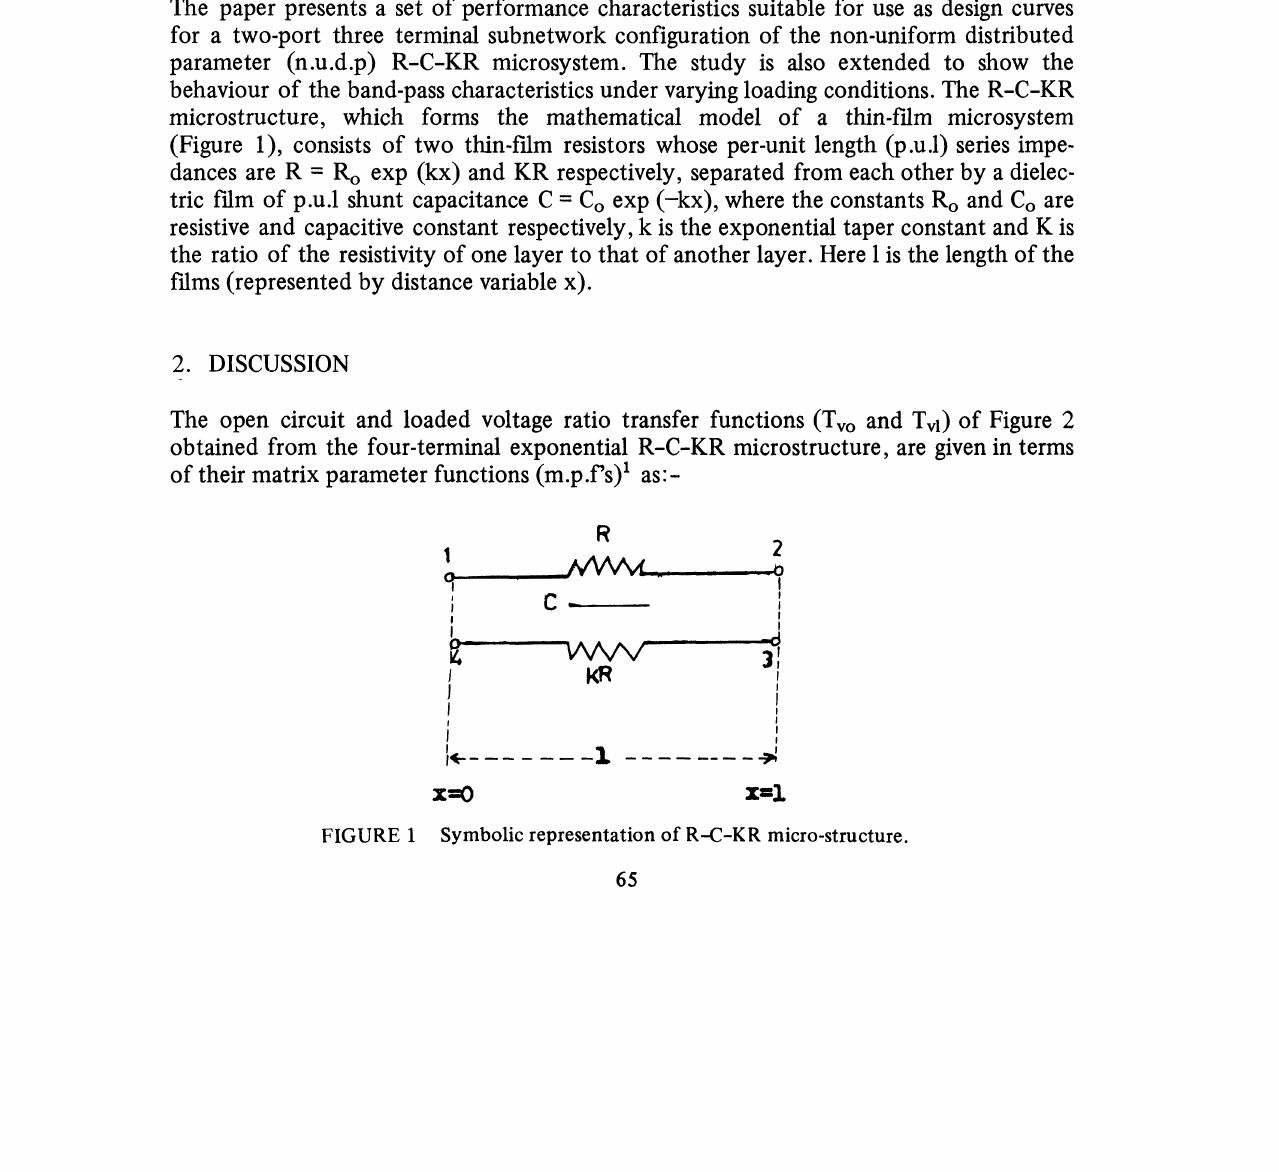
x=O x=l FIGURE Symbolic representation of R--C-KR micro-structure.